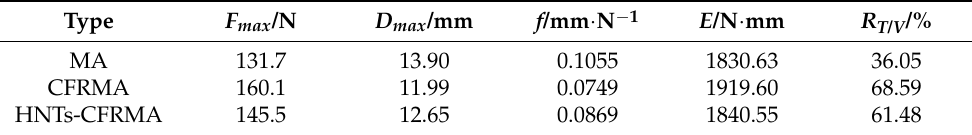
Table 10. Asphalt-based low temperature performance index for force ductility.